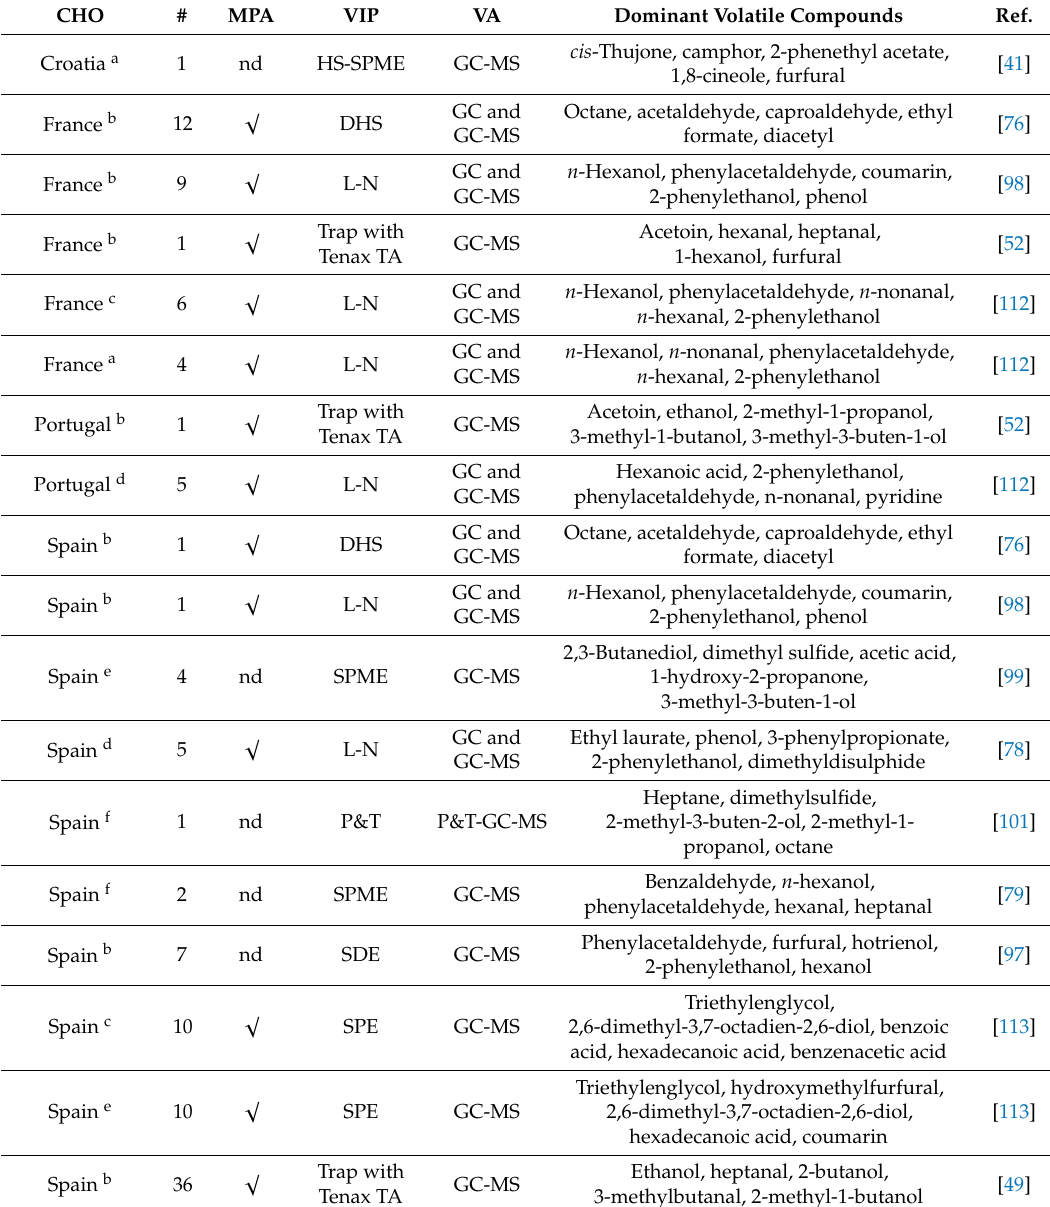
Table 11. Lavender honey’s main volatiles, with reference to the country of origin, number of samples, isolation and analysis procedures and five main volatile components. Unless otherwise specified, the honeybee type was A. mellifera